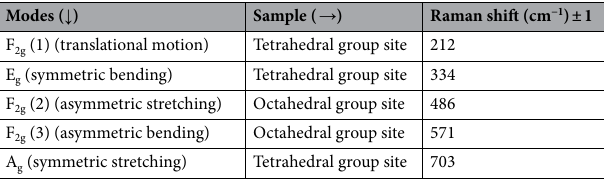
Table 2. Parameters calculated from Raman spectra of NAFO nanoparticles by using intense peaks.